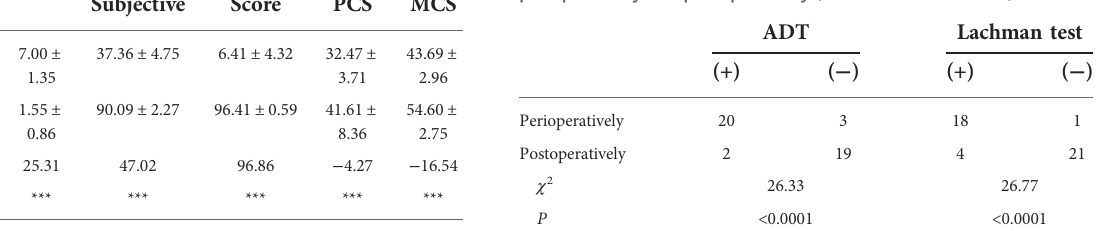
TABLE 2 Patients with objective results of differences between perioperatively and postoperatively (ADT and Lachman